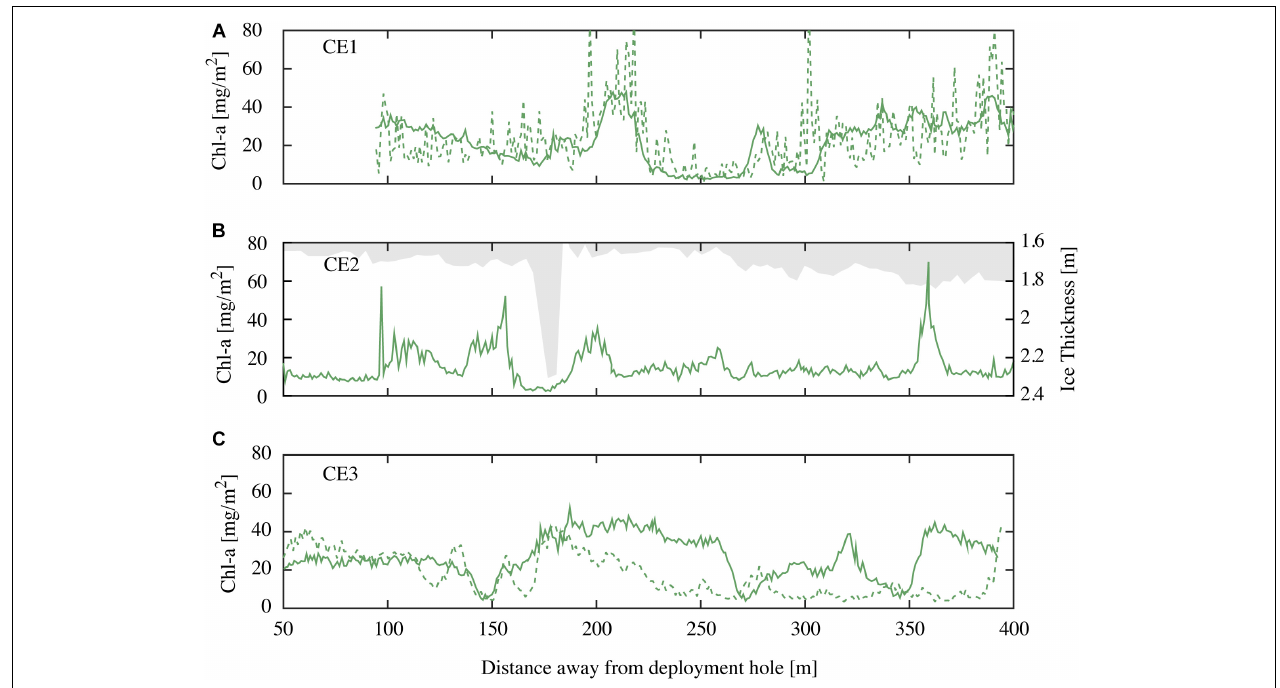
FIGURE 7 | (A) Chl-a values for repeat runs of the outgoing transit leg of CE1 at local time 23:45 04 November 2014 (green dashed line) and 09:00 05 November 2014 (green solid line); (B) chl-a values for CE2 at local 10:45 05 November 2014 (green line) and overhead ice keel depth (bin averaged in 5 m intervals; grayed out) for the incoming transit leg; and (C) chl-a values for outgoing (green line) and incoming (green dashed line) transit legs (spaced at 20 m) for CE3 recorded at local time 09:45 05 November 2014.